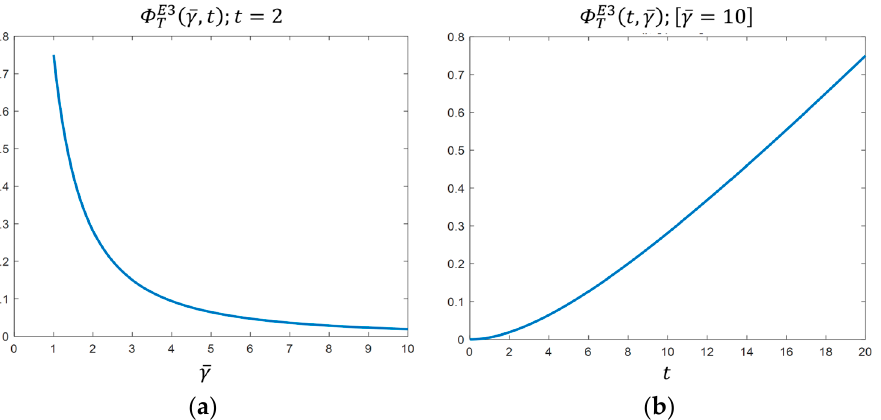
Figure 2. Budget value 𝛾 on the objective function of the planner.